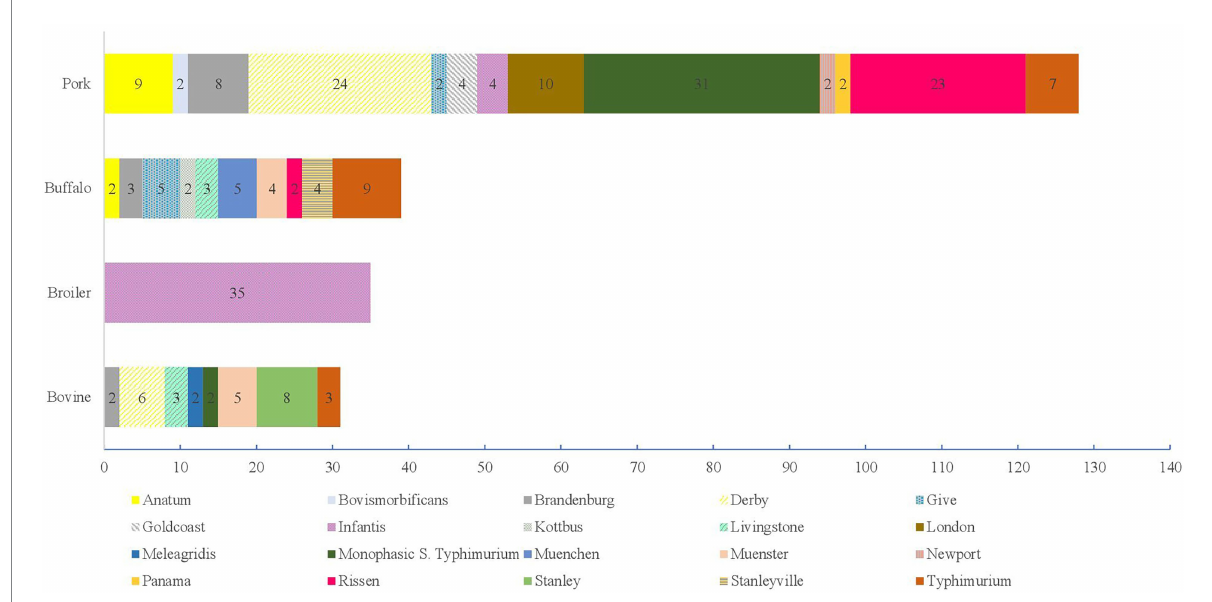
FIGURE 4 Number of Salmonella serovars within the subspecies enterica with an occurrence >1 from 2011 to 2021 isolated from Carcasses from 2011 to